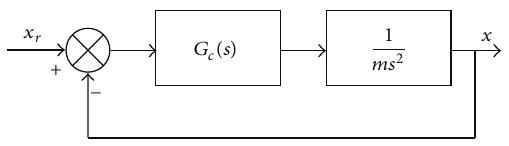
Figure 2: Block scheme of the closed-loop